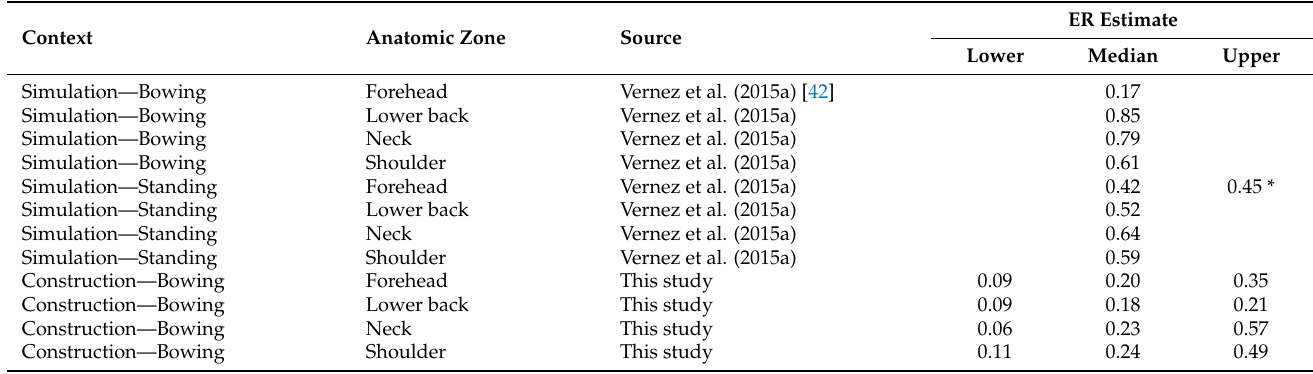
Figure 3. Box and whisker plots showing the empirically determined ERs for each anatomic zone and posture. Although treated the same by the ER model, skiing has been considered separately from the standing arms down posture in the context of builders. The crosses represent the ER value calculated by the Vernez et al. model. Small variations (up to ± 0.02) arose due to varying solar elevation at different times of the year. The number of points for each box plot is shown above the x axis with the number of points excluded (due to a zero reading on the dosimeter assumed to be a hardware failure) shown in parentheses. Table 1. ER values from the Vernez et al. model plus empirical estimates from this study and previous studies with similar contexts, with the lower and upper limits of the range included where possible. N indicates the number of participants or measurements used to estimate the